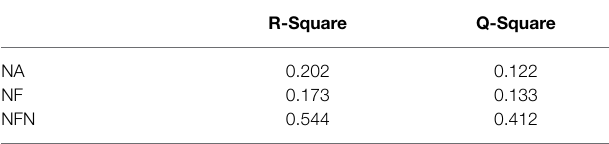
TABLE 4 | R-Square values and Q-Square values for the